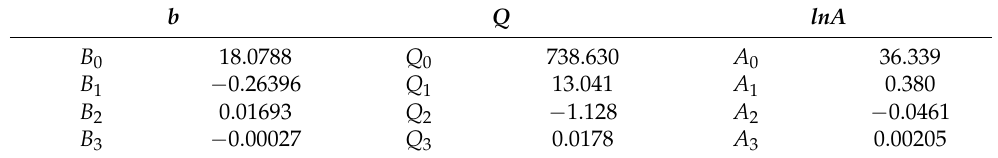
Figure 5. The relationship between the constants and strain: ( a ) the material constant ( b ), ( b ) deformation activation energy Q value, and ( c ) material constant (ln A ). Table 4. Third-order polynomial fitting results of parameters, with strain, for the α + β phase region.